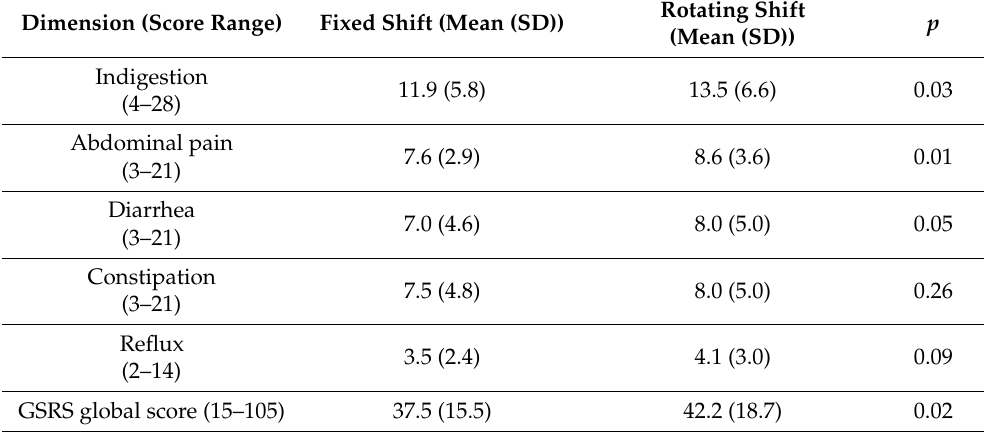
Table 3. GSRS scores.